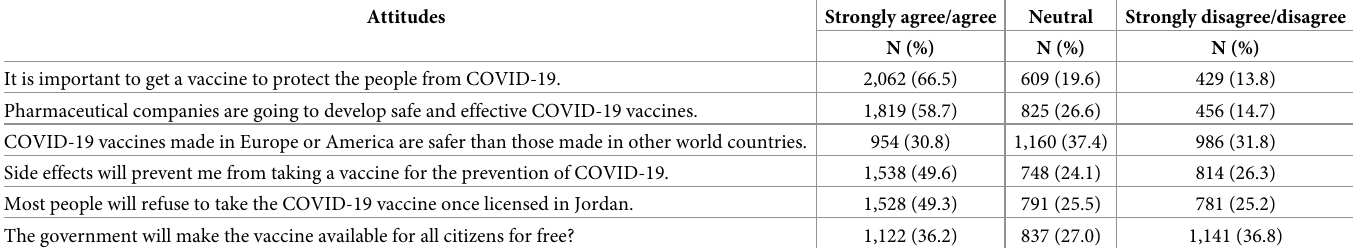
Table 3. Attitudes toward COVID-19